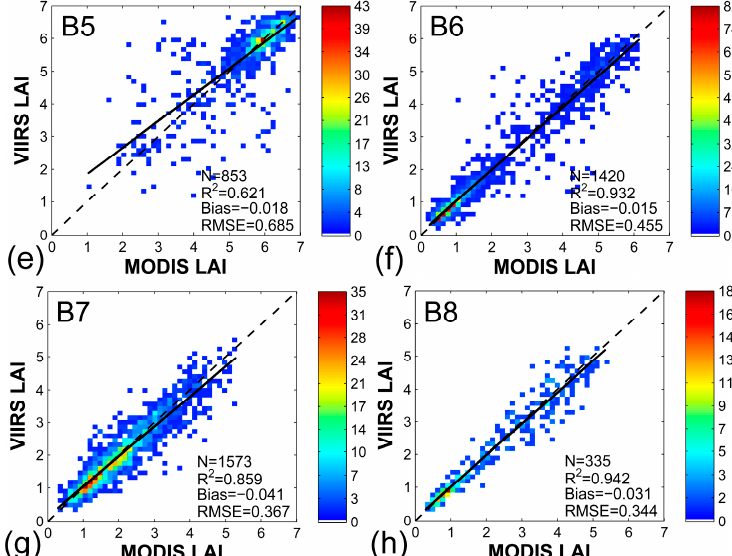
Figure 4. The biome-specific comparison between VIIRS and MODIS LAI retrievals at the site scale from 2012 to 2016. Multiple validation sites adopted from Benchmark Land Multi-site Analysis and Intercomparison of Products 2.1 (BELMANIP-2.1) are used for this comparison. The solid black line is the linear fit for all pixels and the colorbar shows the density of pixels falling at each grid. The ( a – h ) stands for biome 1–8, respectively. The eight biomes are (B1) grasses and cereal crops, (B2) shrubs,